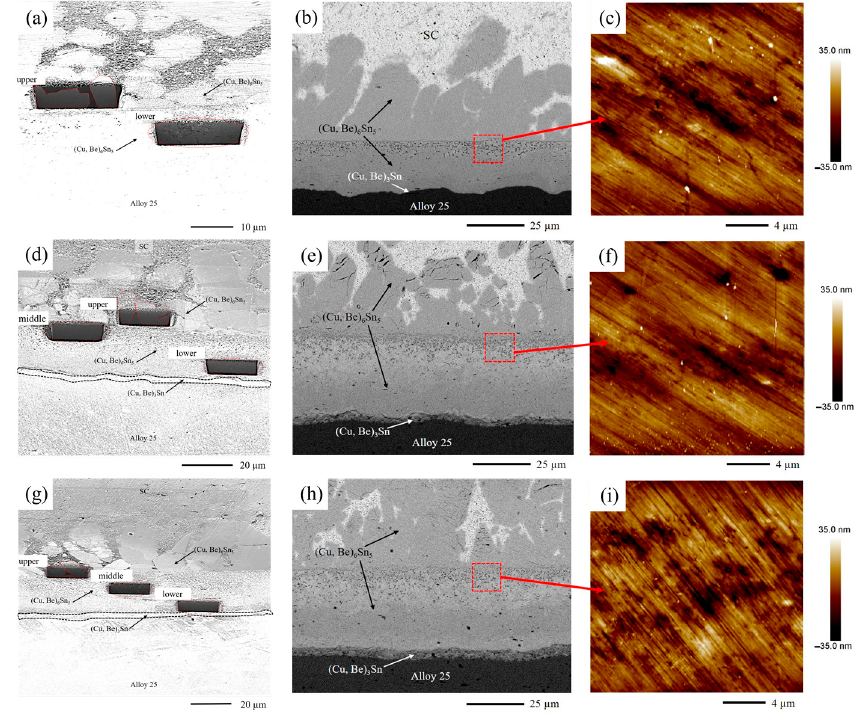
Figure 6. The SC/Alloy 25 reaction couples: ( a ) focused ion beam (FIB) images at 240 ◦ C for 4 h, ( b ) schematic diagram of atomic force microscope (AFM) measurement at 240 ◦ C for 4 h, ( c ) AFM image taken from ( b ), ( d ) FIB images at 255 ◦ C for 4 h, ( e ) schematic diagram of AFM measurement at 255 ◦ C for 4 h, ( f ) AFM image taken from ( e ), ( g ) FIB images at 270 ◦ C for 4 h, ( h ) schematic diagram of AFM measurement at 270 ◦ C for 4 h, ( i ) AFM image taken from ( h